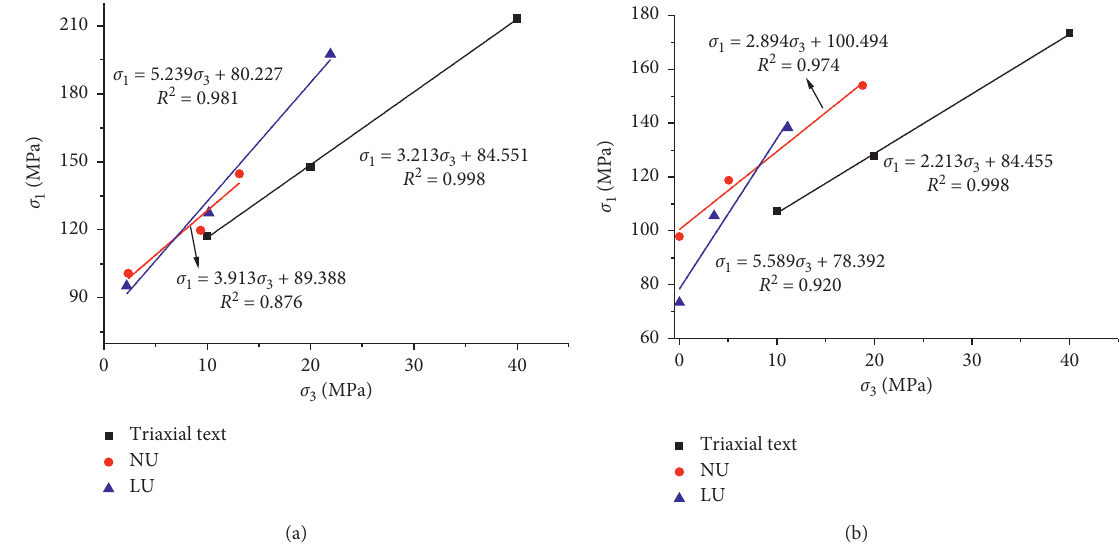
Figure 15: Mohr–Coulomb criterion: (a) V